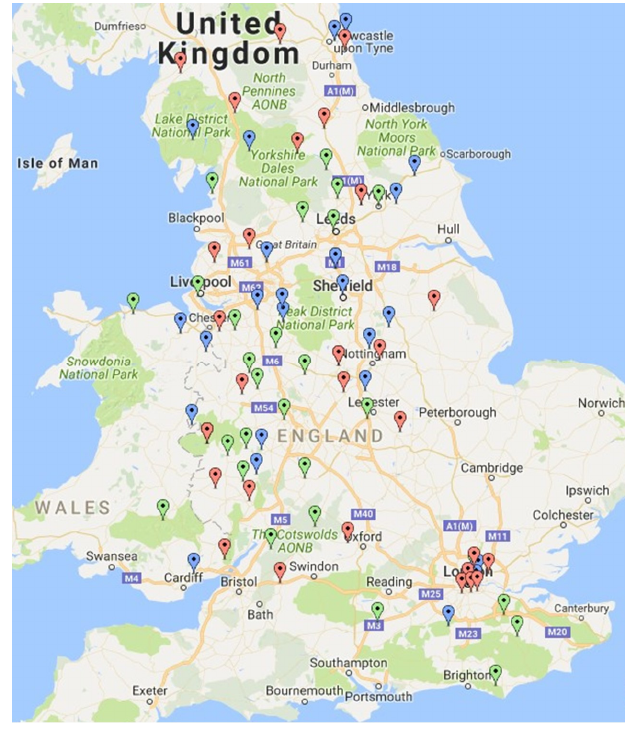
Figure 1. Geographical distribution of respondent craft breweries. Red tabs: craft breweries with a single batch capacity <1000 L; blue tabs: craft breweries with a single batch capacity >1000 L and <2000 L; and green tabs: craft breweries with a single batch capacity >2000 L. The graph was generated from BatchGeo.com.